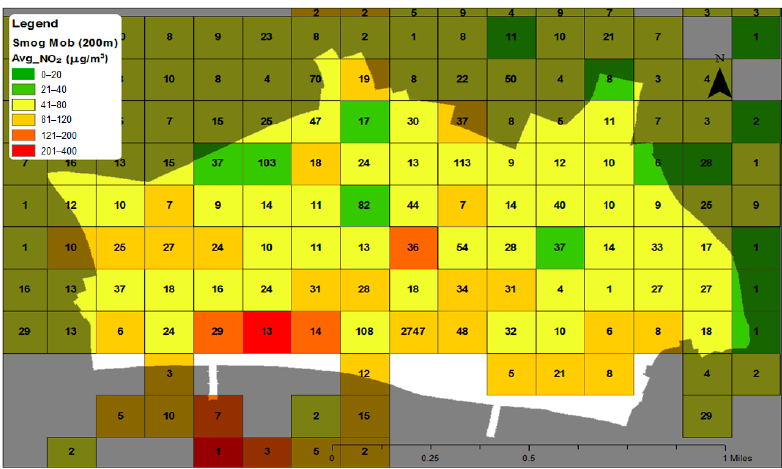
Figure 4. Smogmobile Density Plot (200 m grid